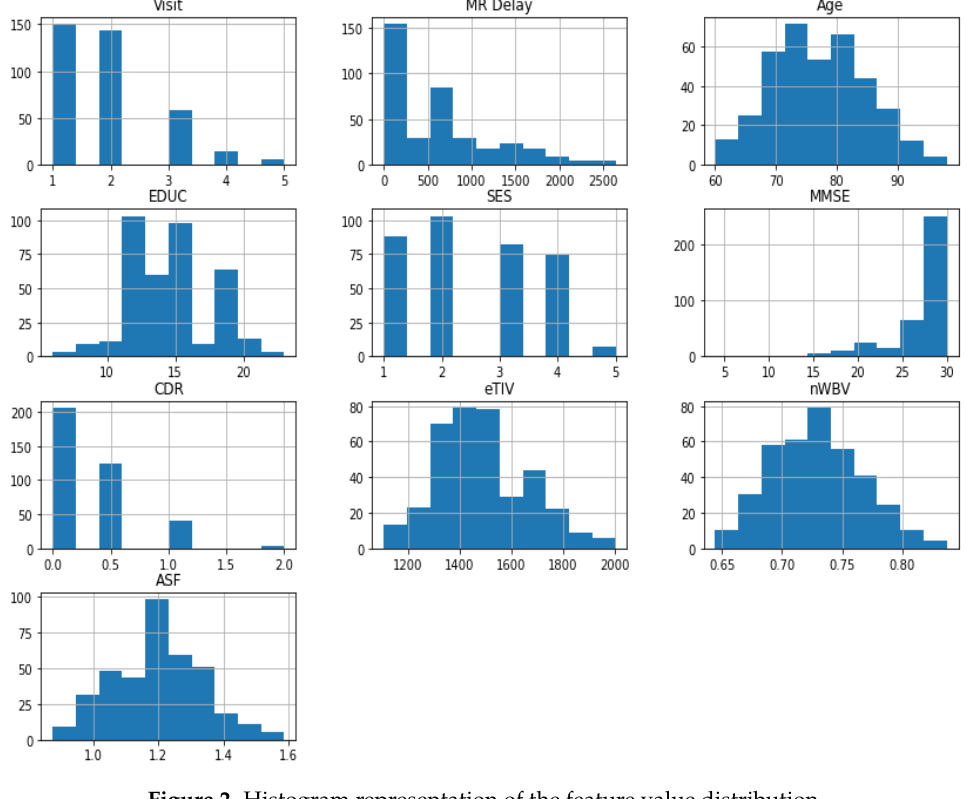
Figure 2. Histogram representation of the feature value distribution.